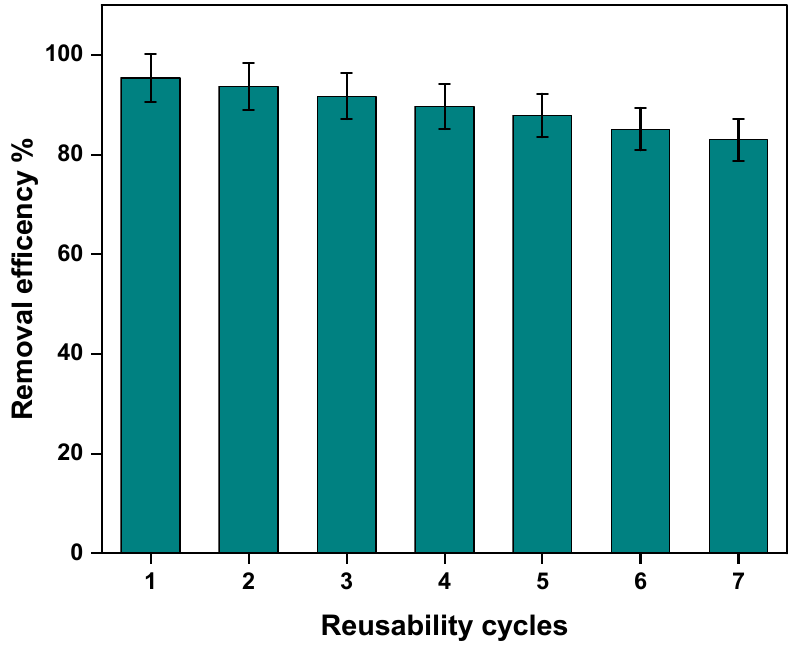
Figure 12. Reusability of the GA-MNPs for the removal of CIP.